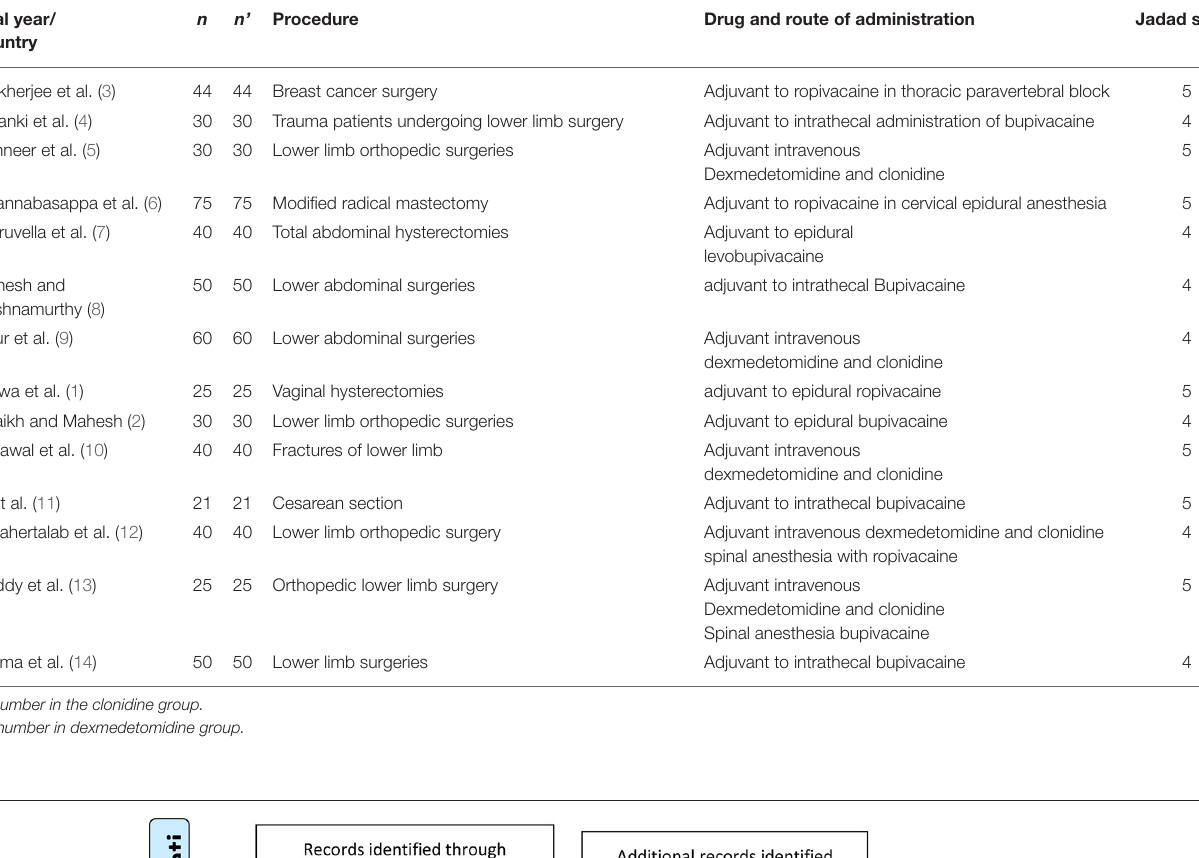
TABLE 1 | Characteristics of included studies in the meta-analysis.